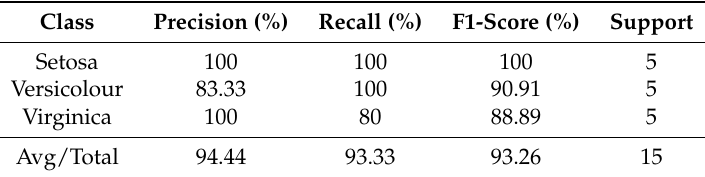
Figure 8. Evaluation with IRIS data. ( a ) Confusion Matrix generated to validate Regulated Activated Networks (RANs) model with IRIS data (having 9 : 1 train and test data ratio) for Class-0 (Setosa), Class-1 (Verisicolour), and Class-2 (Virginica); ( b ) Receiver Operating Characteristics (ROC) curve analysis with IRIS dataset (having 9 : 1 train, and test data ratio), for Class-0 (Setosa), Class-1 (Verisicolour), and Class-2 (Virginica). Table 4. Evaluation of RANs Model generated through IRIS